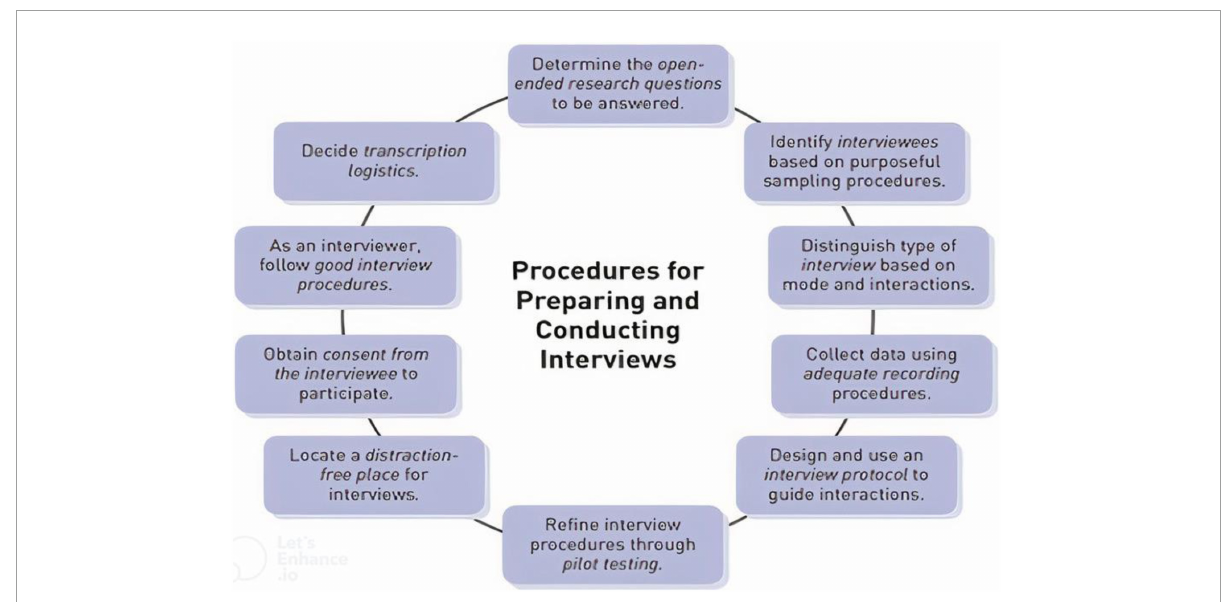
FIGURE1 Procedures for preparing and conducting interviews, adopted from Creswell and Poth (2016, p.